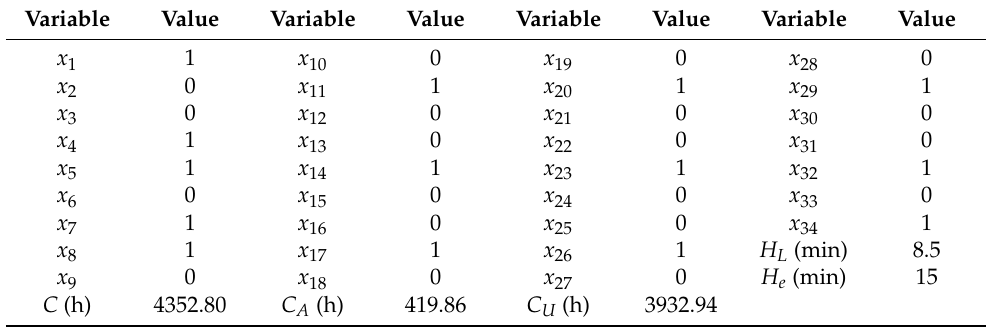
Table 2. The results of the case study in Jinan obtained by the Lingo software. Variable